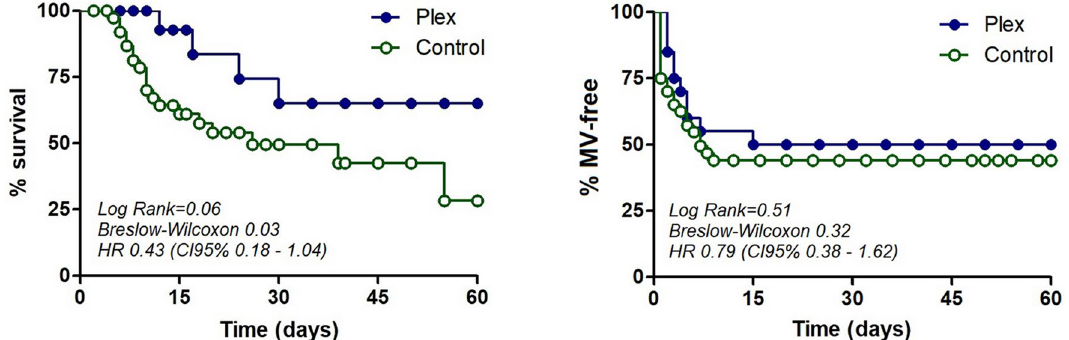
Figure 1. Effect of PLEX on mortality and mechanical ventilation—free time. Kaplan–Meier curves comparing % of survival (left) and % of patients without mechanical ventilation requirement.